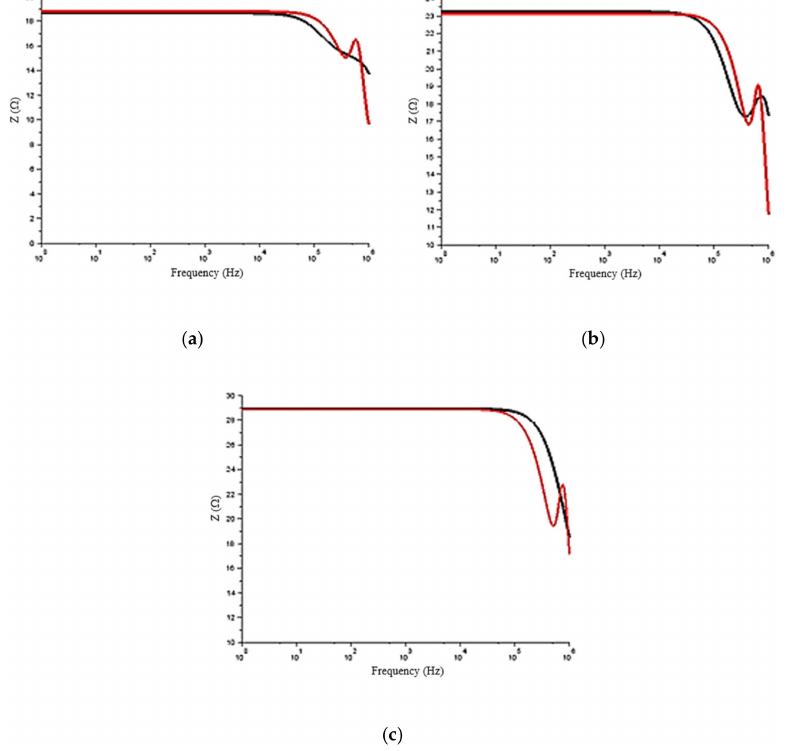
Figure 6. Input impedance of MT6 grounding arrangement in 1 Hz to 1 MHz frequency range. Red line: full circuit model; black line: pi-circuit model. ( a ) ρ g = 1300 Ω · m; ( b ) ρ g = 1600 Ω m; ( c ) ρ g = 2000 Ω